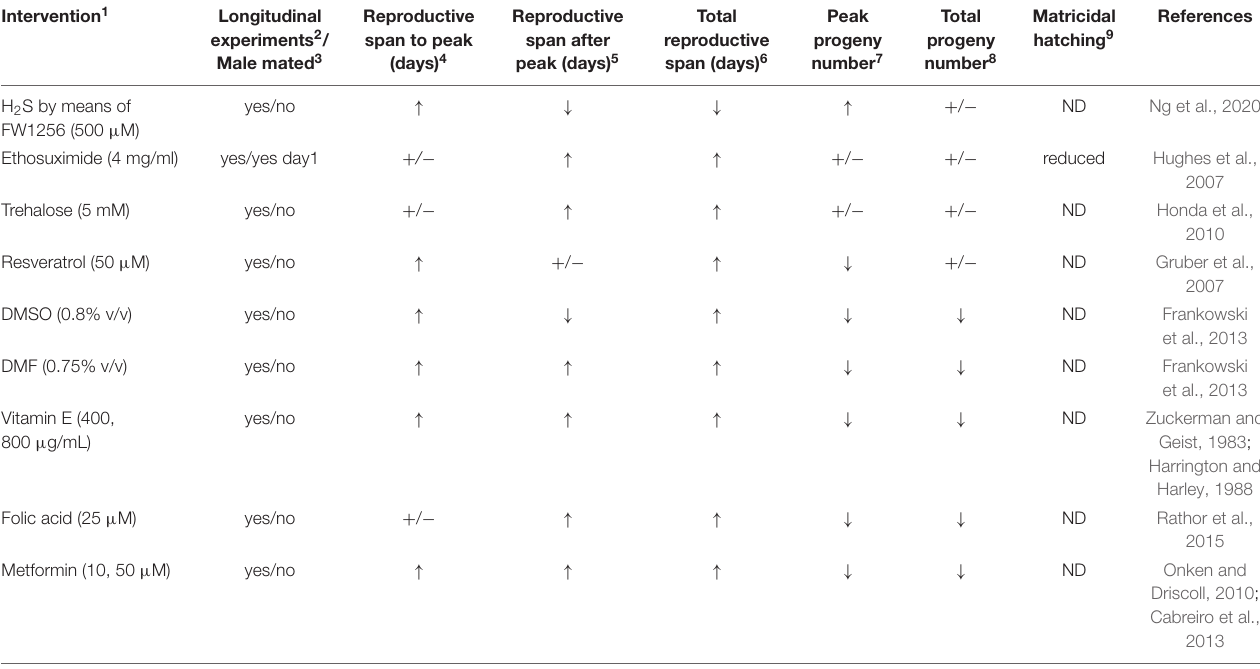
TABLE 1 | Compounds that modulate reproductive aging in Caenorhabditis elegans . Intervention